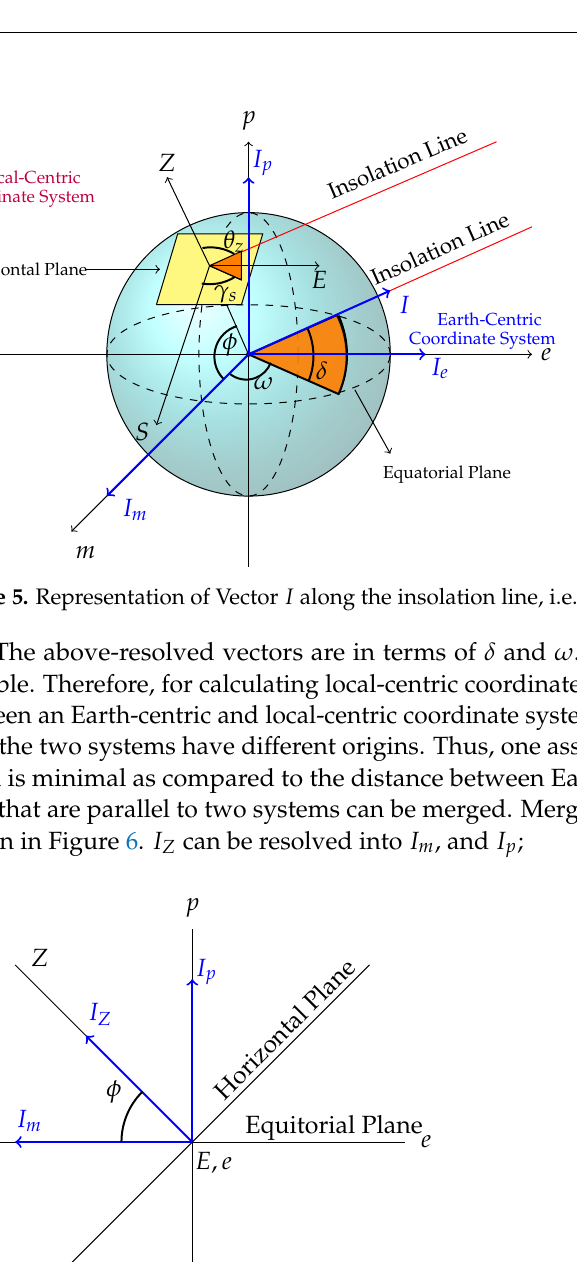
Substituting the value of I m and I p in (13), The modified value for I Z will be